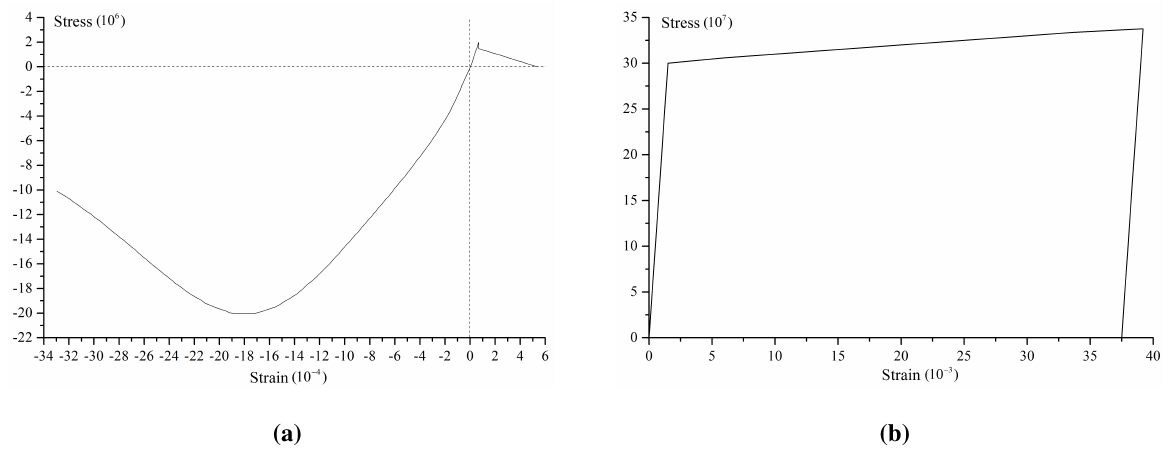
Fig. 1 The stress-strain curve of the materials in the numerical simulation. (a) The concrete and (b) The